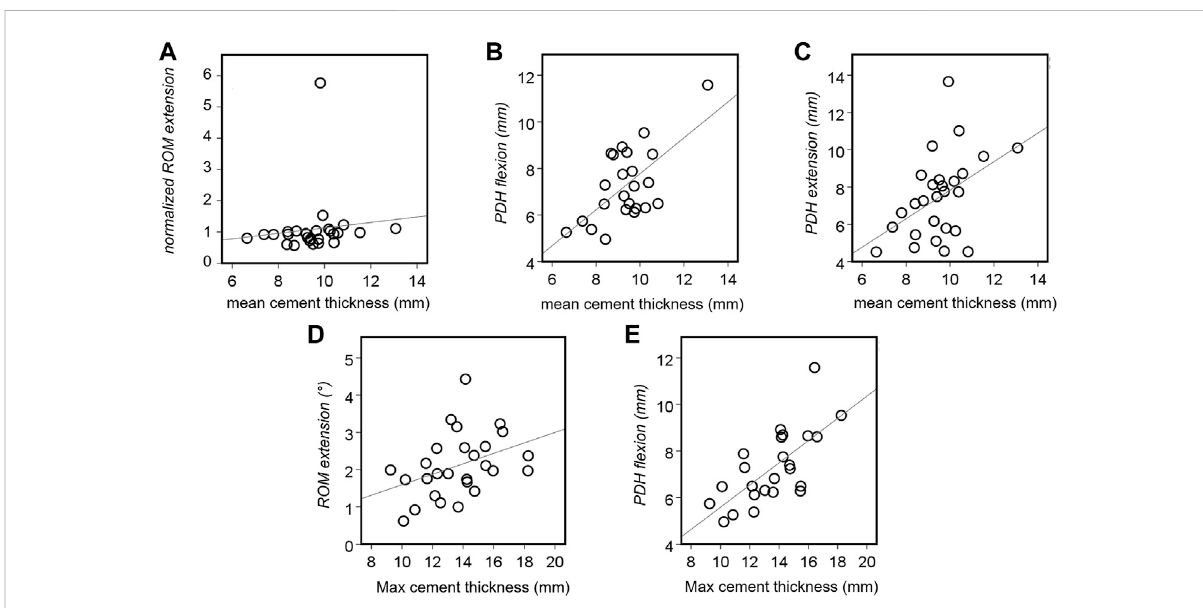
FIGURE 7 Statistically signi fi cant associations between the cement thickness and the biomechanical parameters of the tested specimens. Correlations were found for the ROM in extension ( (A) : p = 0.037 and (D) : p = 0.032), the PDH in extension ( (B) : p = 0.048) and fl exion ( (C) : p = 0.034 and (E) : p <